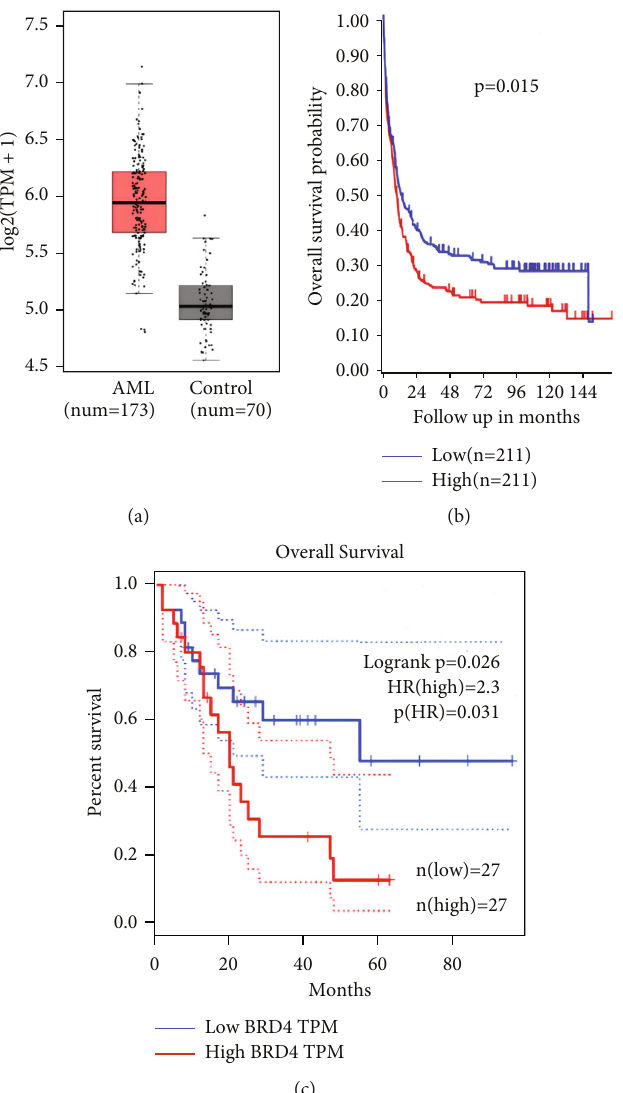
Figure 1: BRD4 is a potentially good target for AML. (a) Expression of BRD4 with AML and normal controls according to the GEPIA database (http://gepia.cancer-pku.cn/index.html). (b) The expected overall survival rate of high BRD4 expression with AML is lower than that of patients with low BRD4 expression, according to the R2 database (https://hgserver1.amc.nl/cgi-bin/r2/main.cgi). (c) The expected overall survival rate of high BRD4 expression in patients with AML is lower than that of patients with low BRD4 expression, according to the GEPIA database